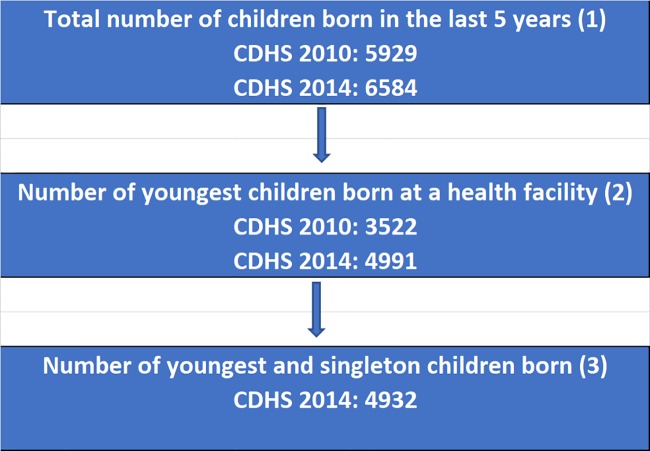
Sample selection diagram.